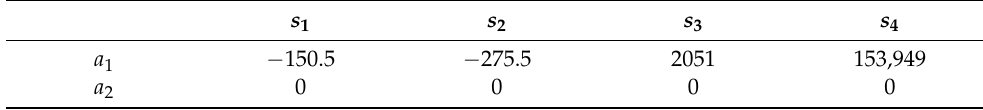
Table 4. Payoffs of the first period actions ( R ( a i ; s l )) .